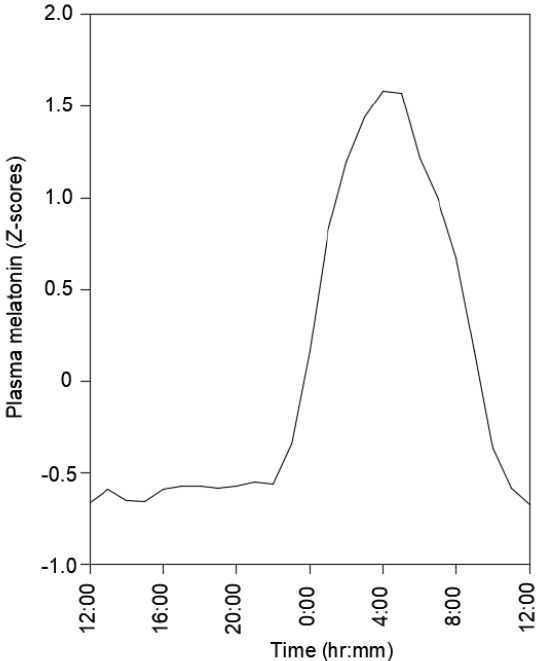
Figure 1. Melatonin variation in plasma over a 24 h period—drawn from data reported in Dijk et al. [5] for seven 21–25 year old males, presented as Z-scores to reduce variability.